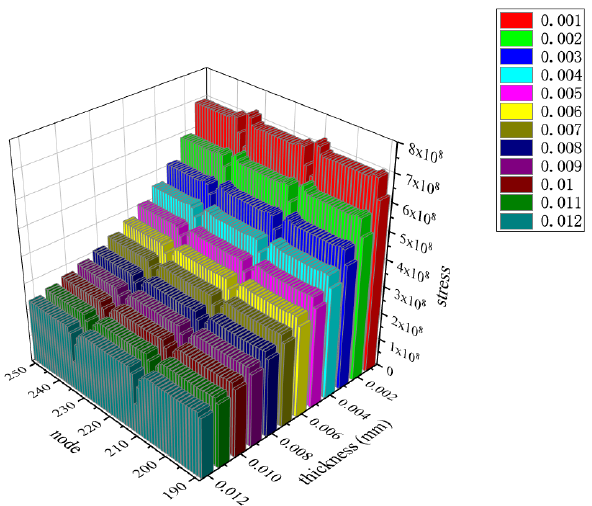
Figure 12. Stress changes under different thicknesses at ply angles of 45, − 45, 0. When the ply angle is 45, − 45, 0, the stress value decreases with the increase of the ply thickness, and the decreasing trend become smaller and smaller.